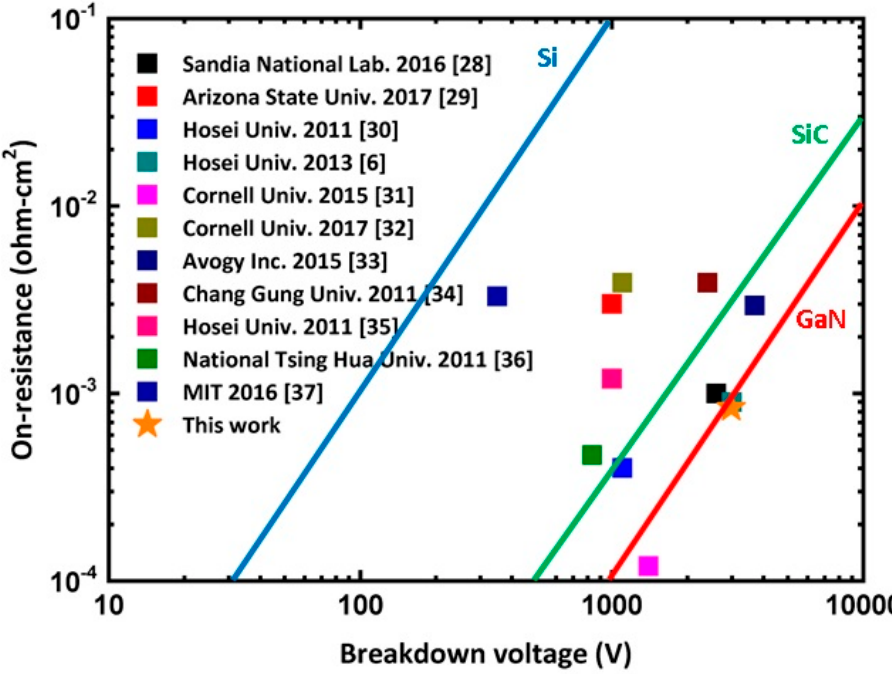
Figure 10. Benchmarks from other reports of vertical GaN p-i-n diodes [28–37].